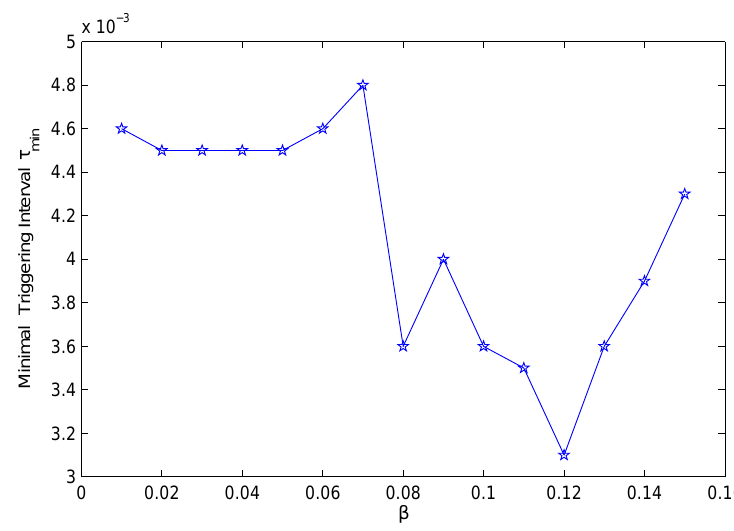
Figure 5. Contour map of cost upper bound with respect to β and γ .